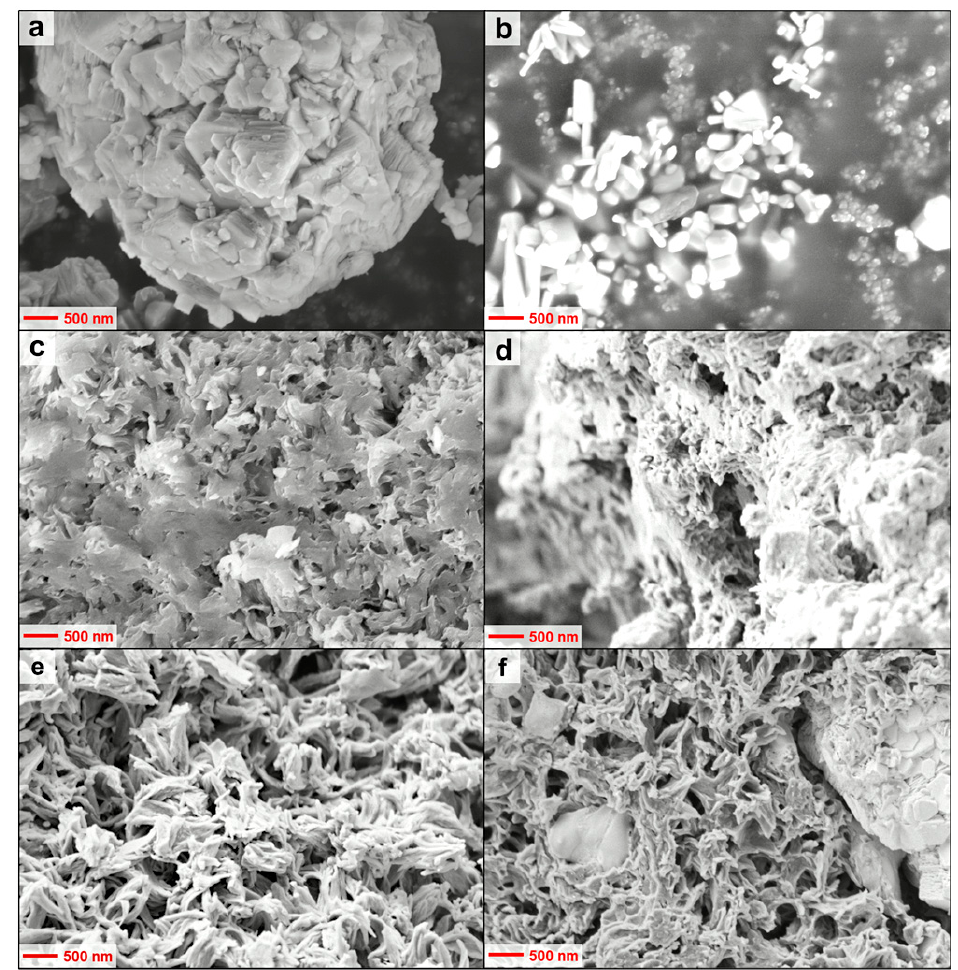
Figure 1. SEM-images of ( a ) NiO, ( b ) ZnO, ( c ) PIn, ( d ) PIn/NiO, ( e ) PIn/ZnO, ( f ) PNZ-3. Nickel oxide used for the synthesis has a layered agglomerated structure of nano- and microparticles (Figure 1a) [23]. The flat particles are irregular and stacked on top of each other. They lead to a compact morphology. In contrast, the ZnO particles consist of various shapes, e.g., small rods and rectangles, which appear in clusters due to agglomer- ation [24]. The mean diameters of the individual NiO and ZnO particles were determined